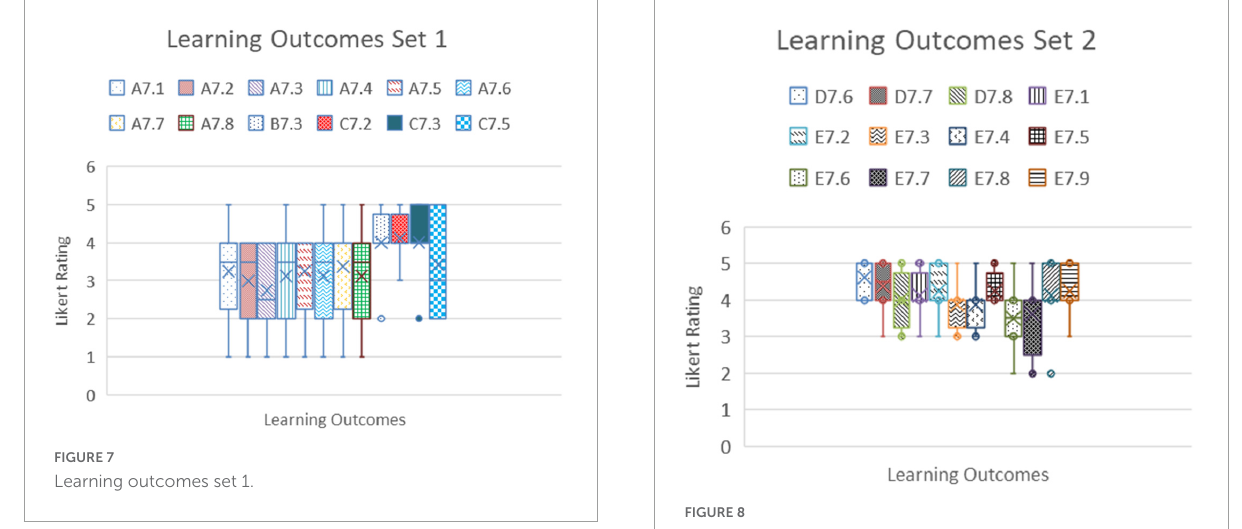
FIGURE8 Learning outcomes set